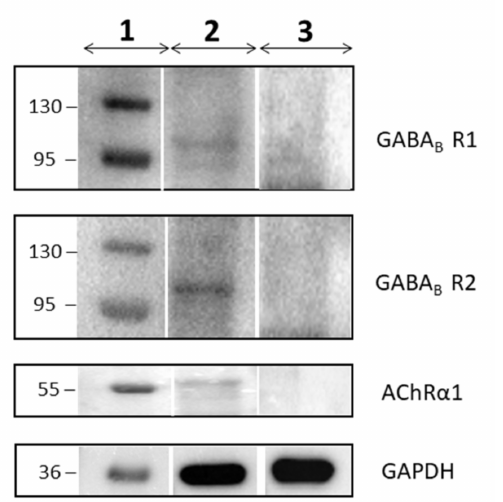
Figure 4. The image shows the Western Blot analysis for GABABR1, GABABR2, AChR α 1 and GAPDH proteins about the hPDLSCs and the DPK-SKDF-H lineage. The column 1 represents the protein molecular weight markers, the column 2 the hPDLSCs and the column 3 the DPK-SKDF-H. The analysis shows the expression of the protein for each of them in hPDLSCs, but there is no expression in